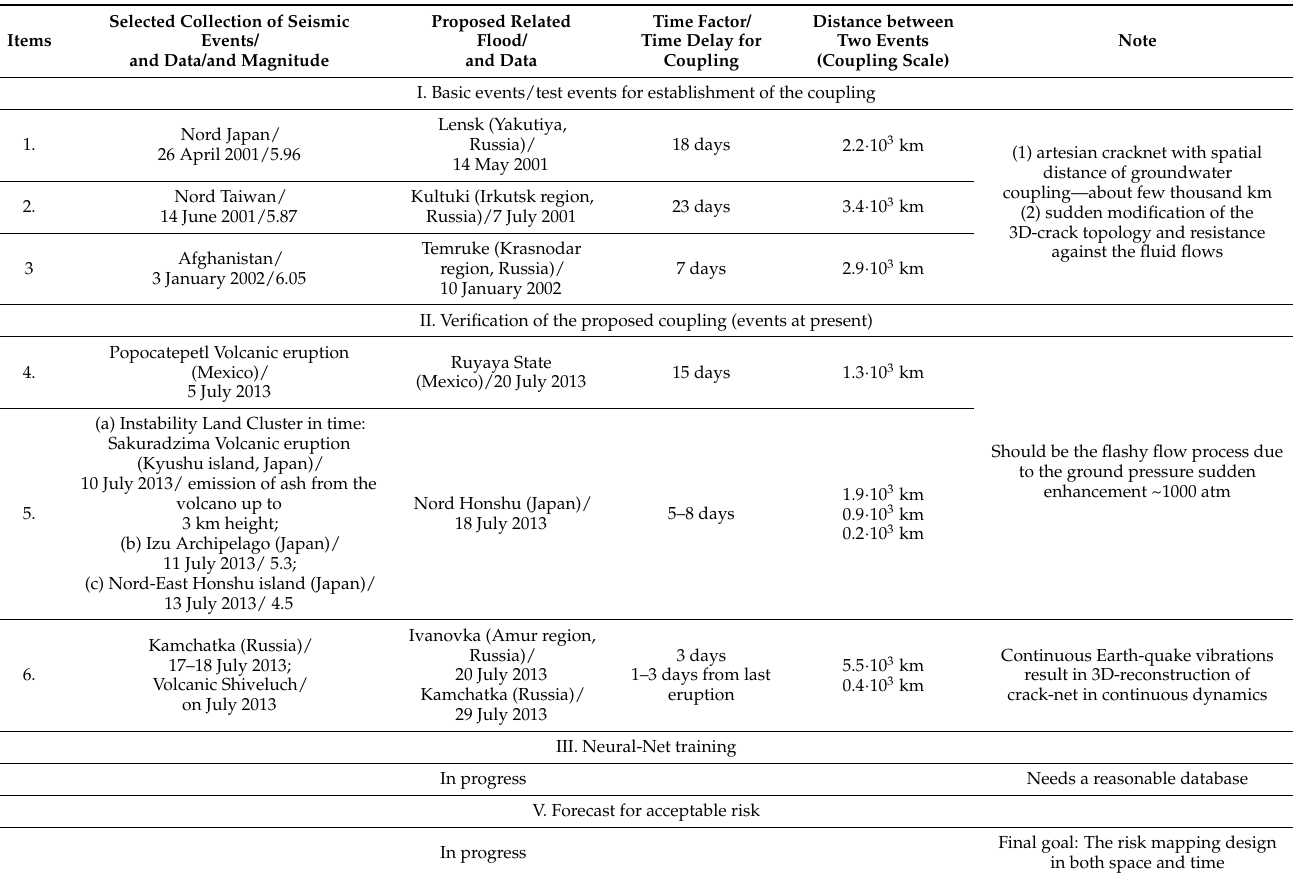
Table 3. Tectonic processes, flood locations and probable